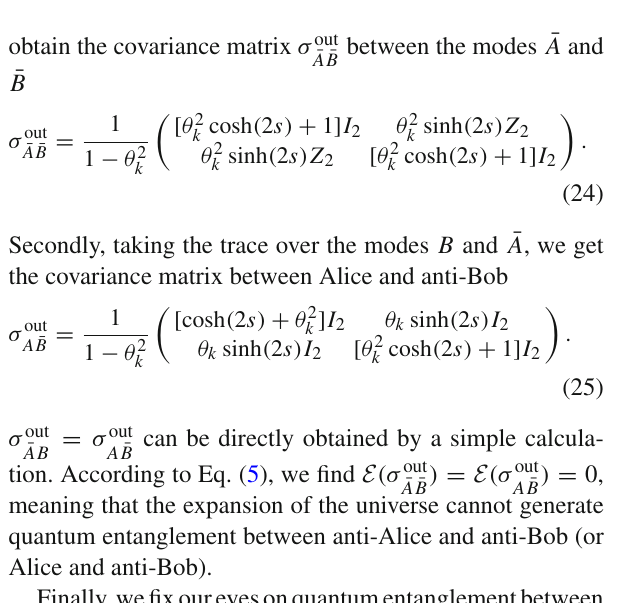
) between the modes A and B as a function of the expansion rate σ for different momentums k , with the Fig. 1 a Quantum entanglement E (σ out AB ) as a function of the mass m for different expansion volumes (cid:9) , with the fixed fixed values of m = (cid:9) = s = 1. b Quantum entanglement E (σ out AB values of k = σ = s =